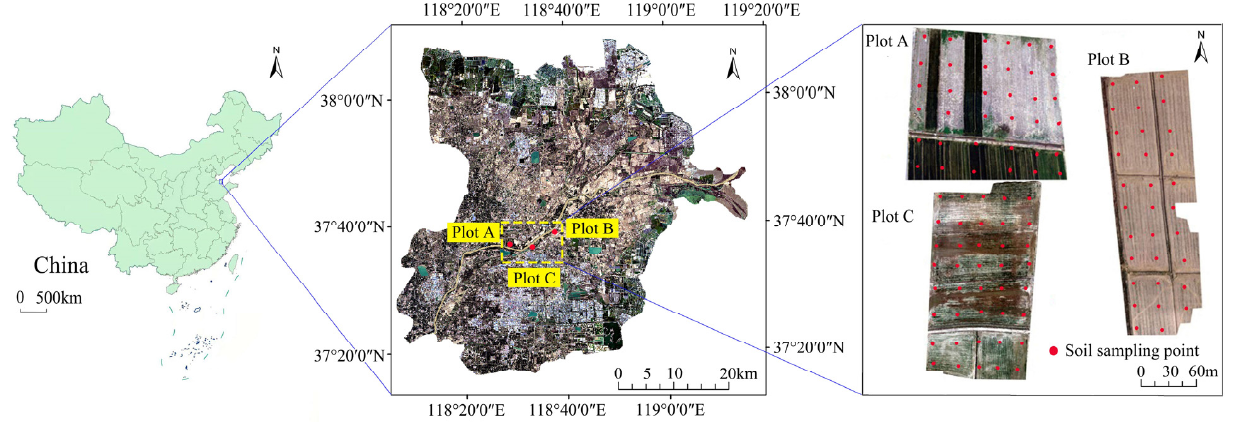
Figure 1. Locations of the study area and test plots.